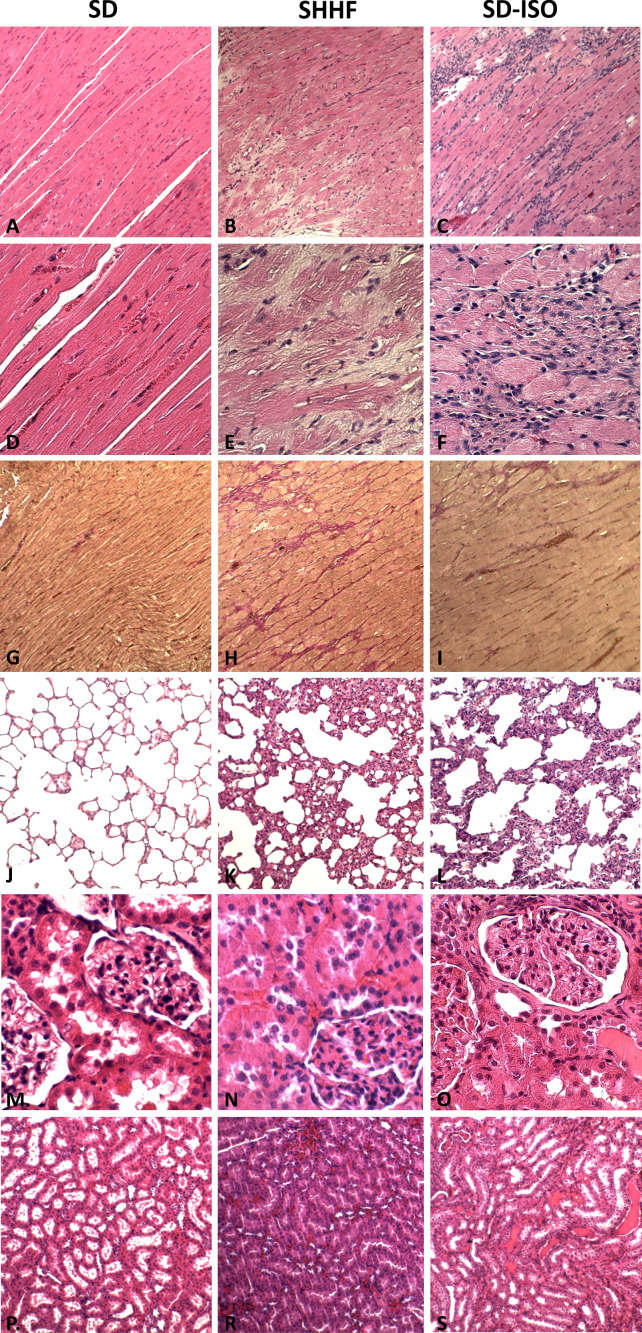
Comparison of the histopathological picture between SD, SHHF and ISO-SD.A, B, C - myocardium; hematoxylin-eosin staining at magnification x10; D, E, F - myocardium; hematoxylin-eosin staining at magnification x40; G, H, I- myocardium; van Gieson staining at magnification x10; J, K, L - lungs; hematoxylin-eosin staining at magnification x10; M, N, O – kidney - renal cortex, renal bodies; hematoxylin-eosin staining at magnification x40; P, T, S – kidney - renal medulla; hematoxylin-eosin staining at magnification x10.